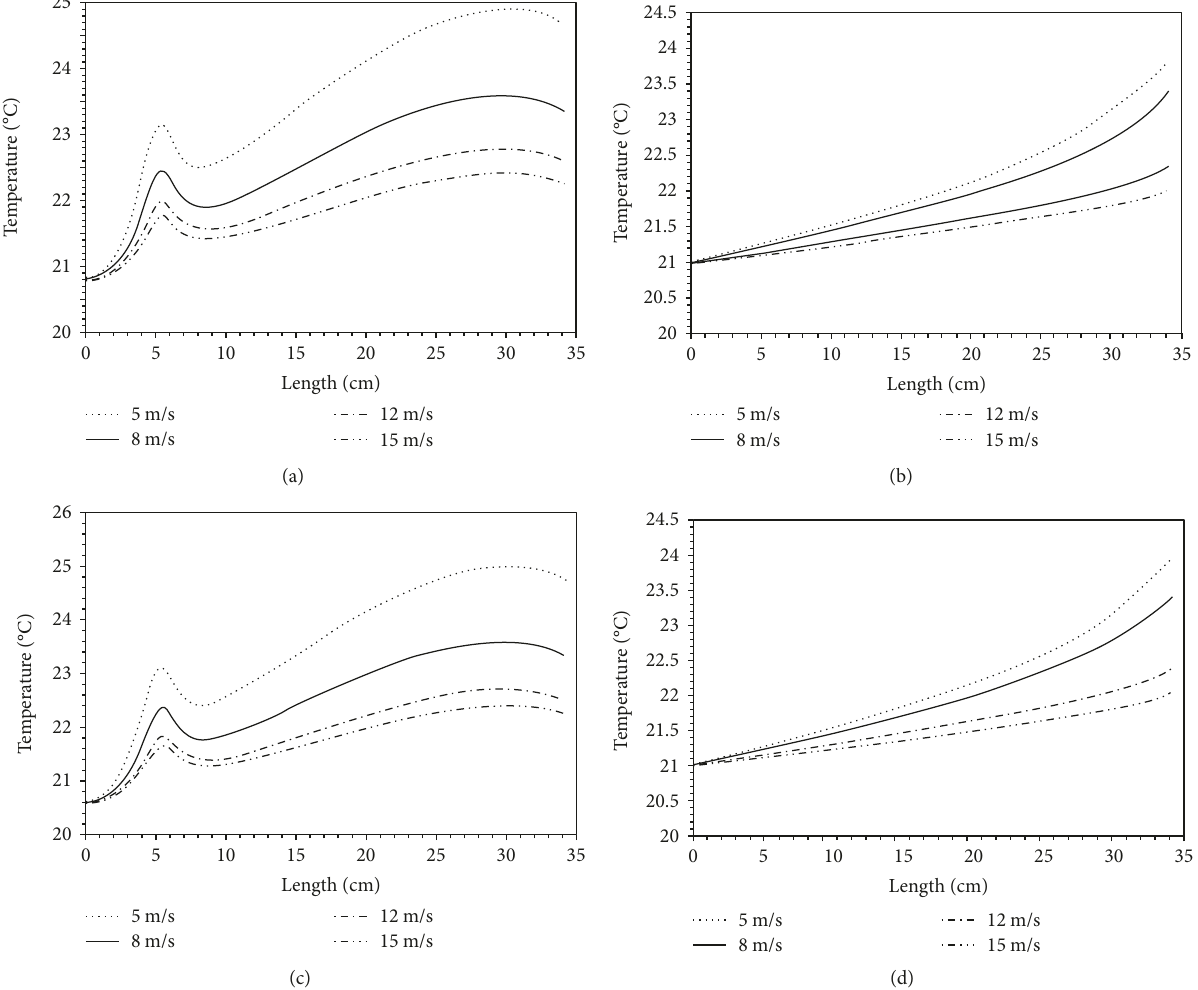
Figure 5: PV module surface temperature along length. (a) Monocrystalline at 0 ° , (b) monocrystalline at 10 ° , (c) polycrystalline at 0 ° , and (d) polycrystalline at 10 °